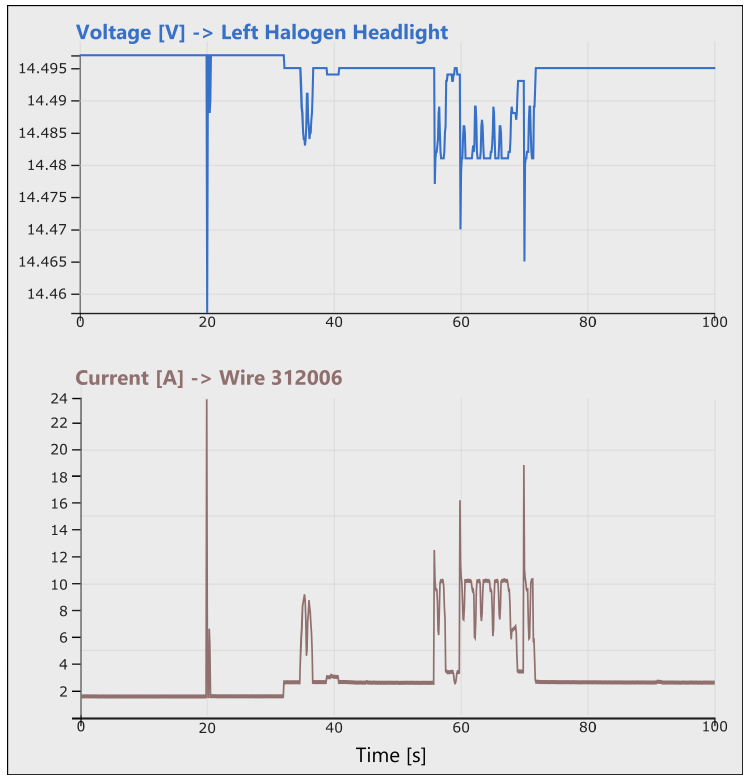
Figure 9. Simulation time-plots